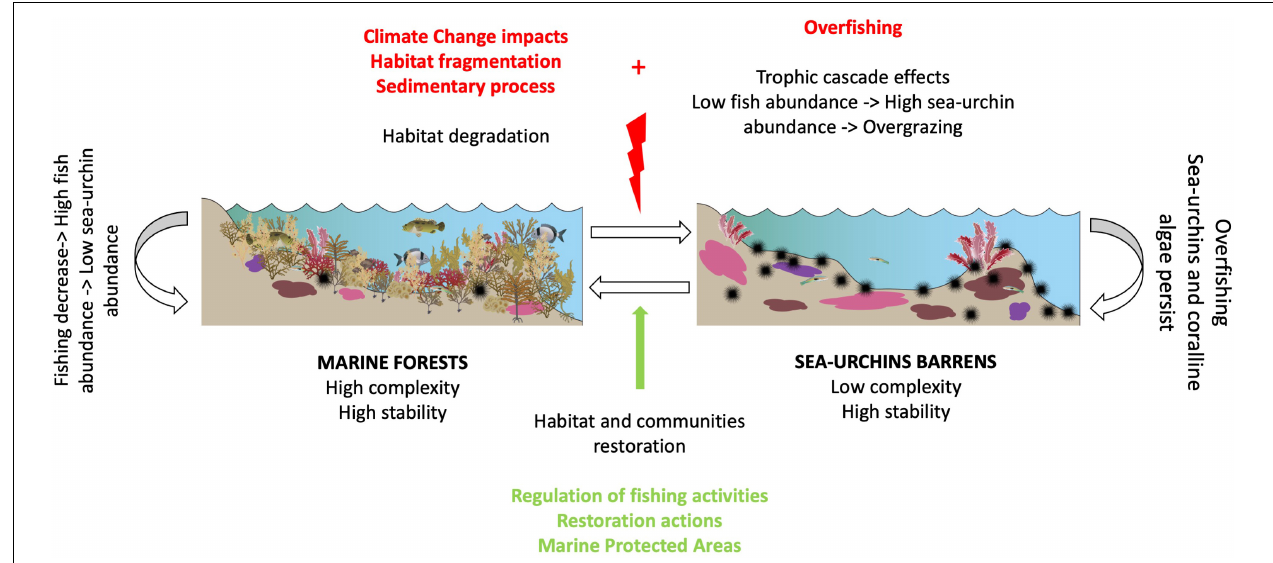
FIGURE 1 | Diagram illustrating the two-system rocky benthic bottoms: marine forests and sea-urchins barrens. Transition processes between states depending on fishing activities and habitat degradations impacts (modified from Sala et al., 1998) (Symbols courtesy of the Integration and Application Network, University of Maryland Center for Environmental Science